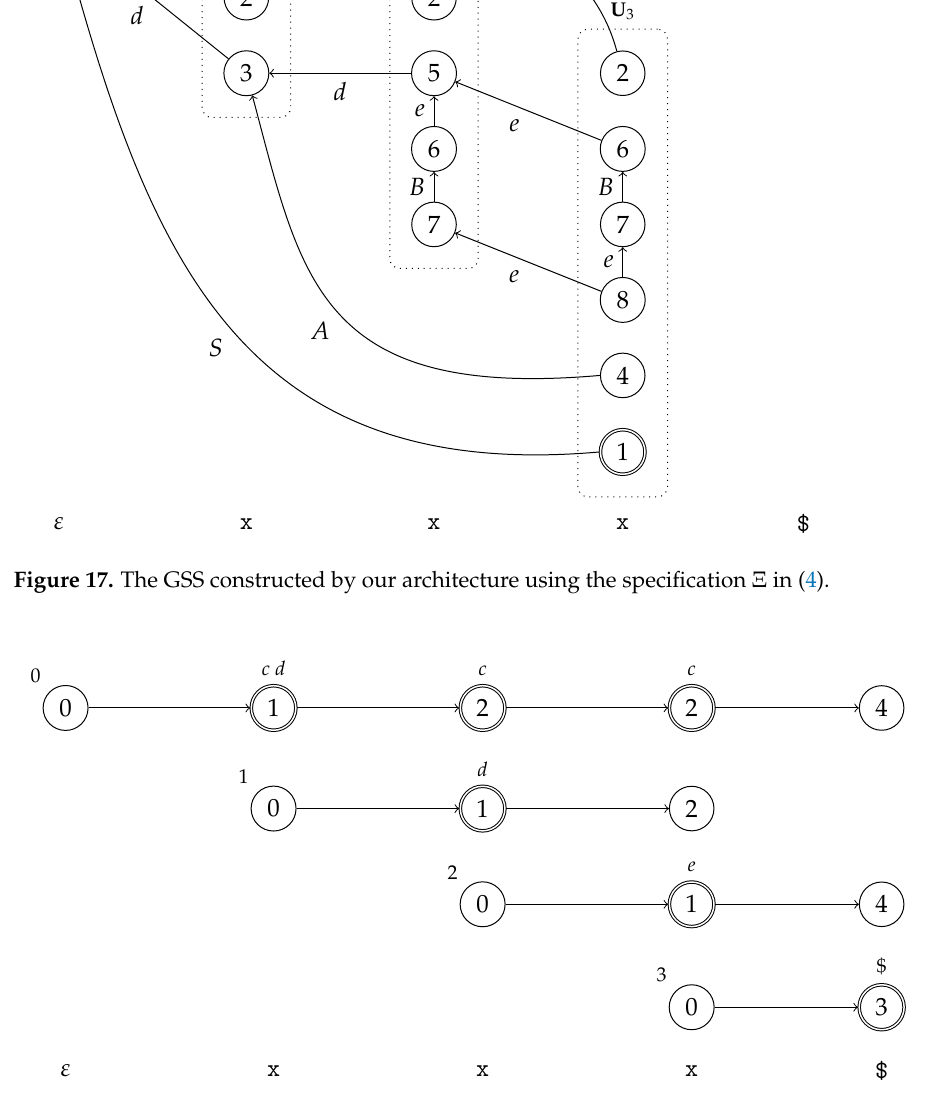
Figure 18. The scanner trace outlining the paths taken through the scanner automaton using the spec- ification Ξ in